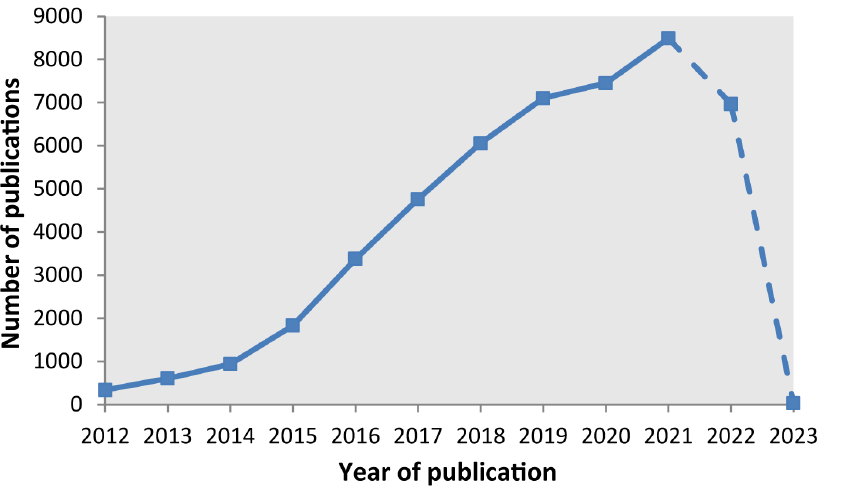
Figure 1. Number of publications focused on smart